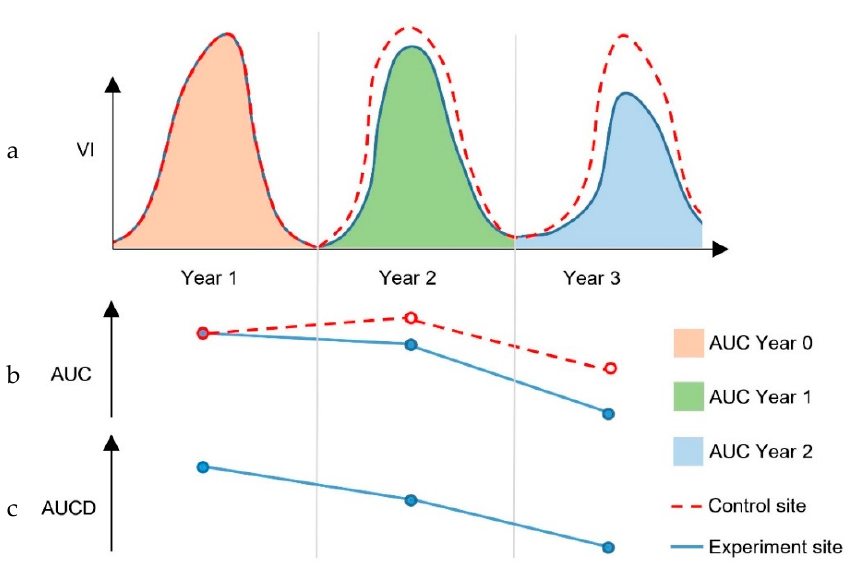
Figure 3. Diagram of the behavior of a Vegetation Index (VI) in a specific plot over three years and its areas under the curve ( AUC ) in hypothetical experiment and control plots. AUCD represents the di ff erence in AUC between control and experiment plots.